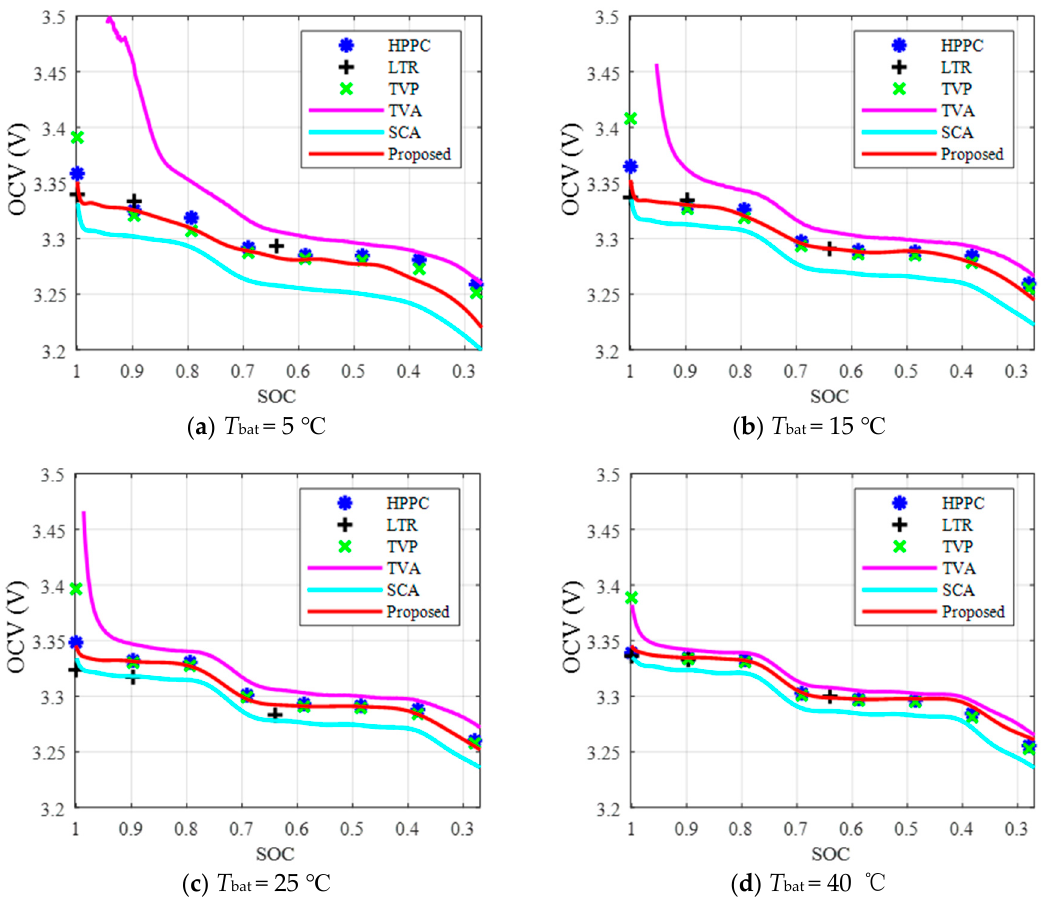
Figure 11. Estimation results of different methods. ( a ) T bat = 5 ℃ ; ( b ) T bat = 15 ℃ ; ( c ) T bat = 25 ℃ ; ( d ) T bat = 35 ℃ .